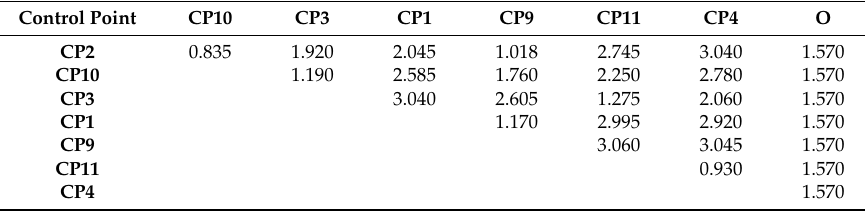
Table 2. Measured distances and fictitious observations (units in (m)).